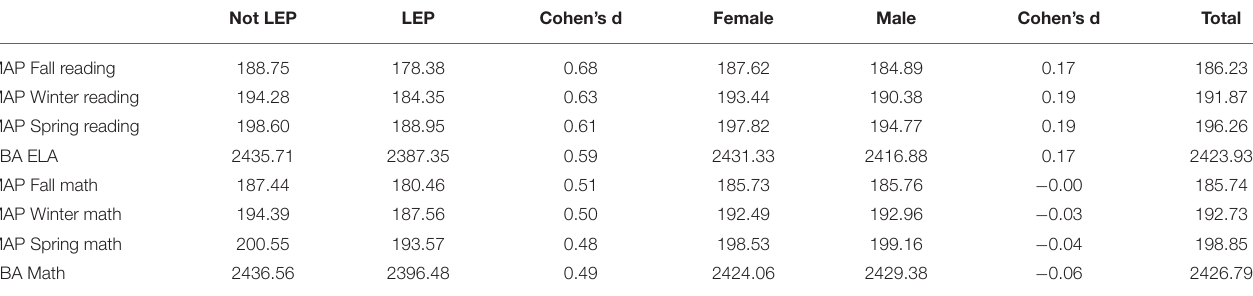
TABLE A1 | MAP and SBA means for the raw scores by Limited English Proficiency (LEP) and by Gender. Not LEP